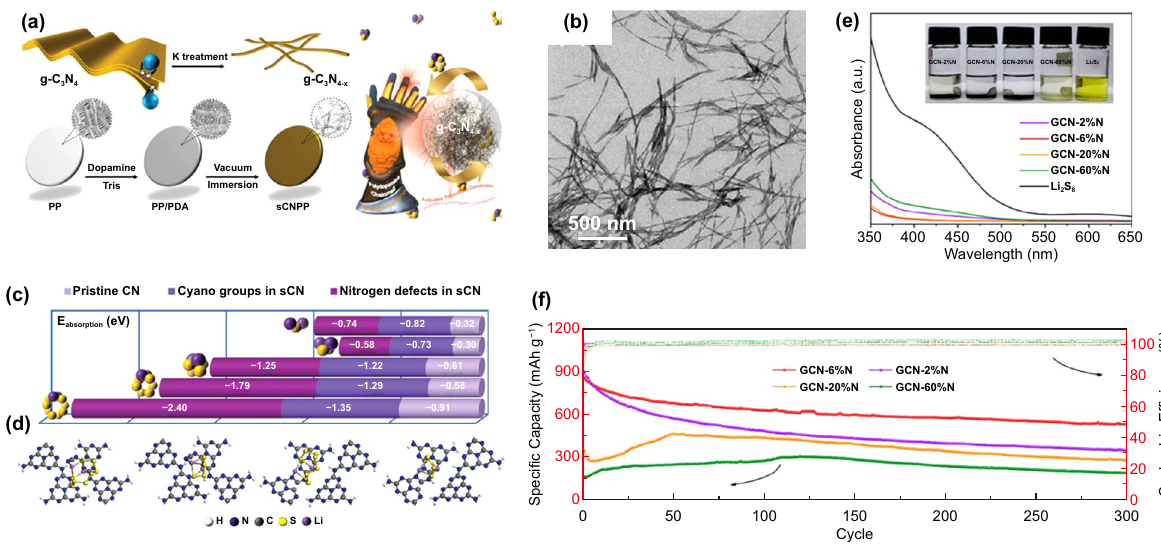
Fig. 4 a Schematic illustration of the preparation process of sCN/PDA/PP separator. b TEM images of sCN. c Adsorption energies for Li 2 S, Li 2 S 2 , Li 2 S 4 , Li 2 S 6 and Li 2 S 8 on pristine CN, the cyano group of sCN and the N vacancy of sCN. d The stable adsorption models of Li 2 S 8 or Li 2 S 4 on the cyano group of sCN and the N vacancy of sCN [58]. Copyright 2021, Wiley–VCH. e UV–Vis spectra of a bare Li 2 S 8 solution and Li 2 S 8 solutions with different GCN materials after aging for 24 h; the inset is the corresponding optical photograph. f Cycling performance of cells with different GCN/S cathodes at 0.5C [46]. Copyright 2020, American Chemical